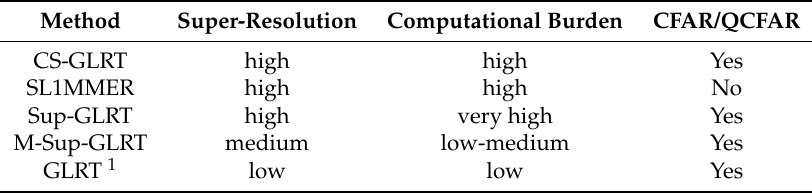
Table 2. Performance